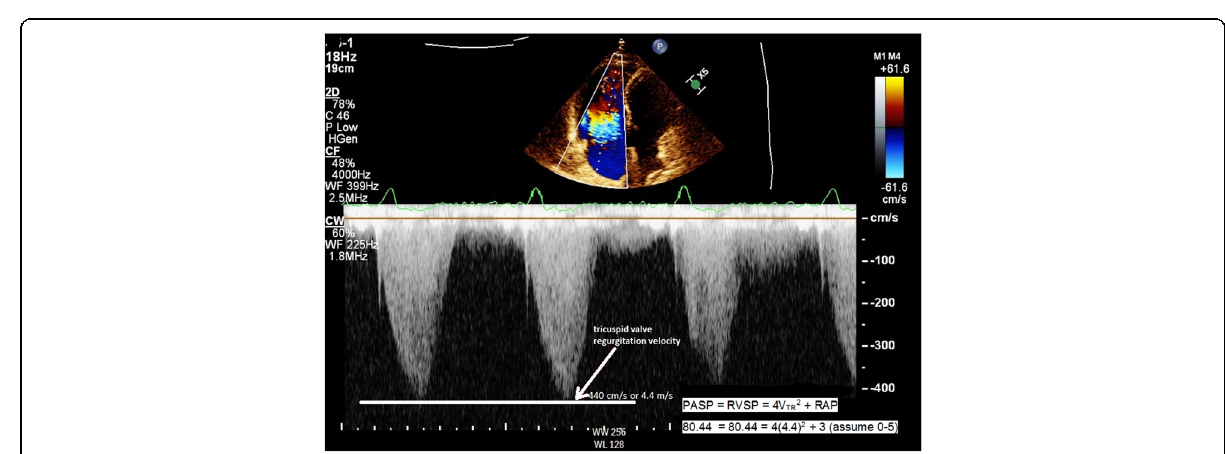
Fig. 16 Pulmonary artery systolic pressure (PASP) calculated from a tricuspid jet on echocardiogram. Estimation of PASP utilizing the tricuspid regurgitation jet velocity can be performed according the depicted equation where RVSP is right ventricle systolic pressure and RAP is right atrial pressure which is the same as Jugular venous